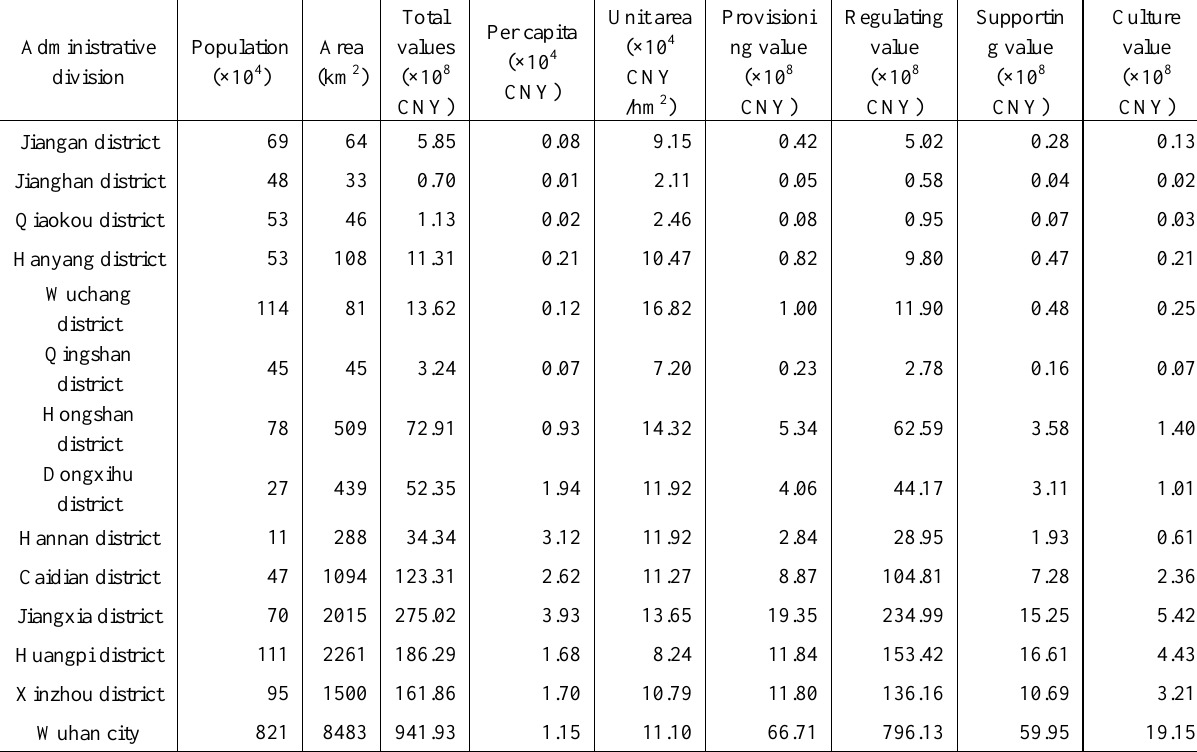
Table 1. Statistical analysis results of ESV from the view of ecosystem service